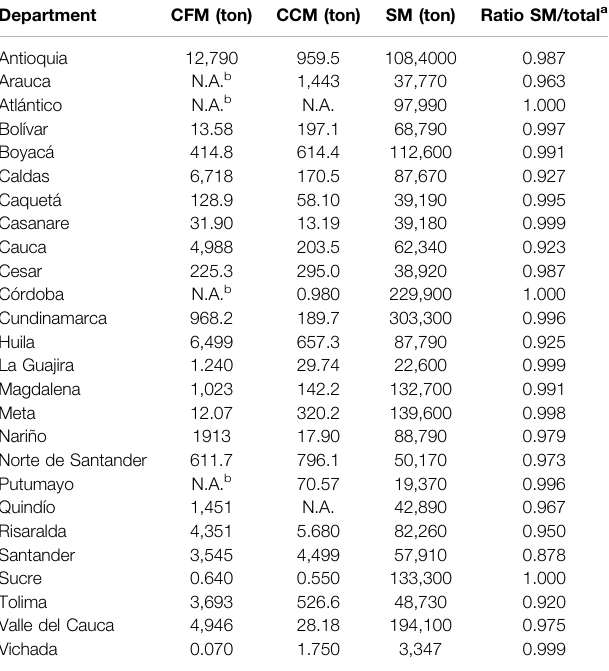
TABLE 3 | Total available amounts of CFM, CCM, and SM (wet mass) in 2017. Department